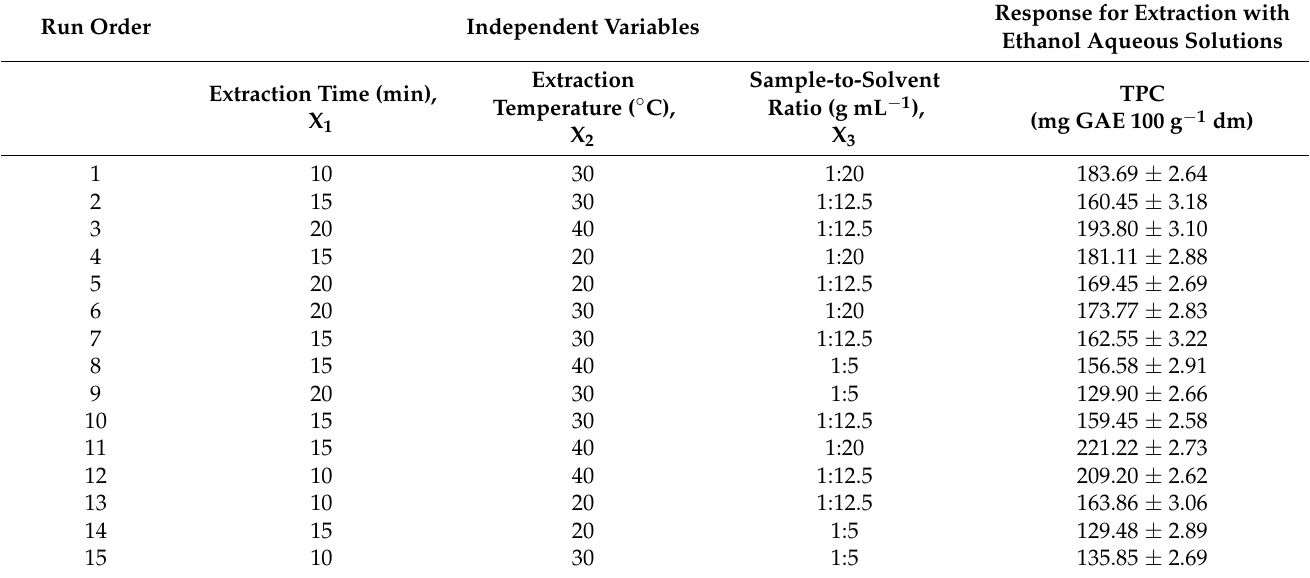
Table 4. Box-Behnken design applied for phenolic compound extraction from black quinoa seeds with ethanol aqueous solutions: run conditions and measured response